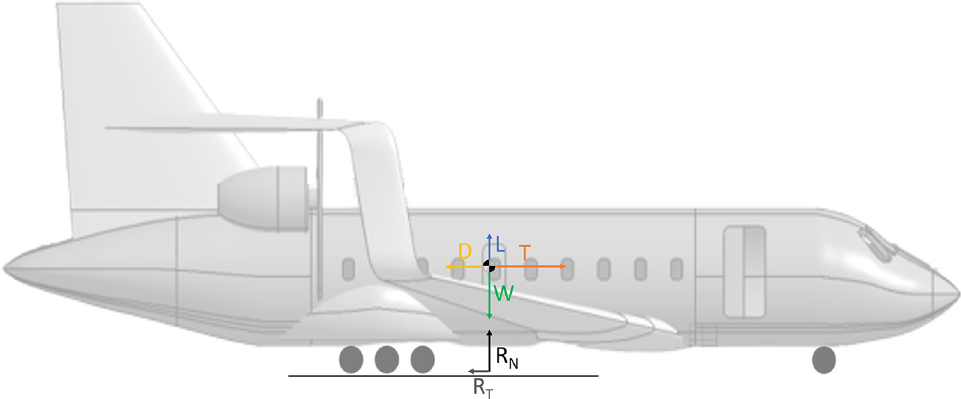
Fig. 15. Forces acting on the aircraft during the